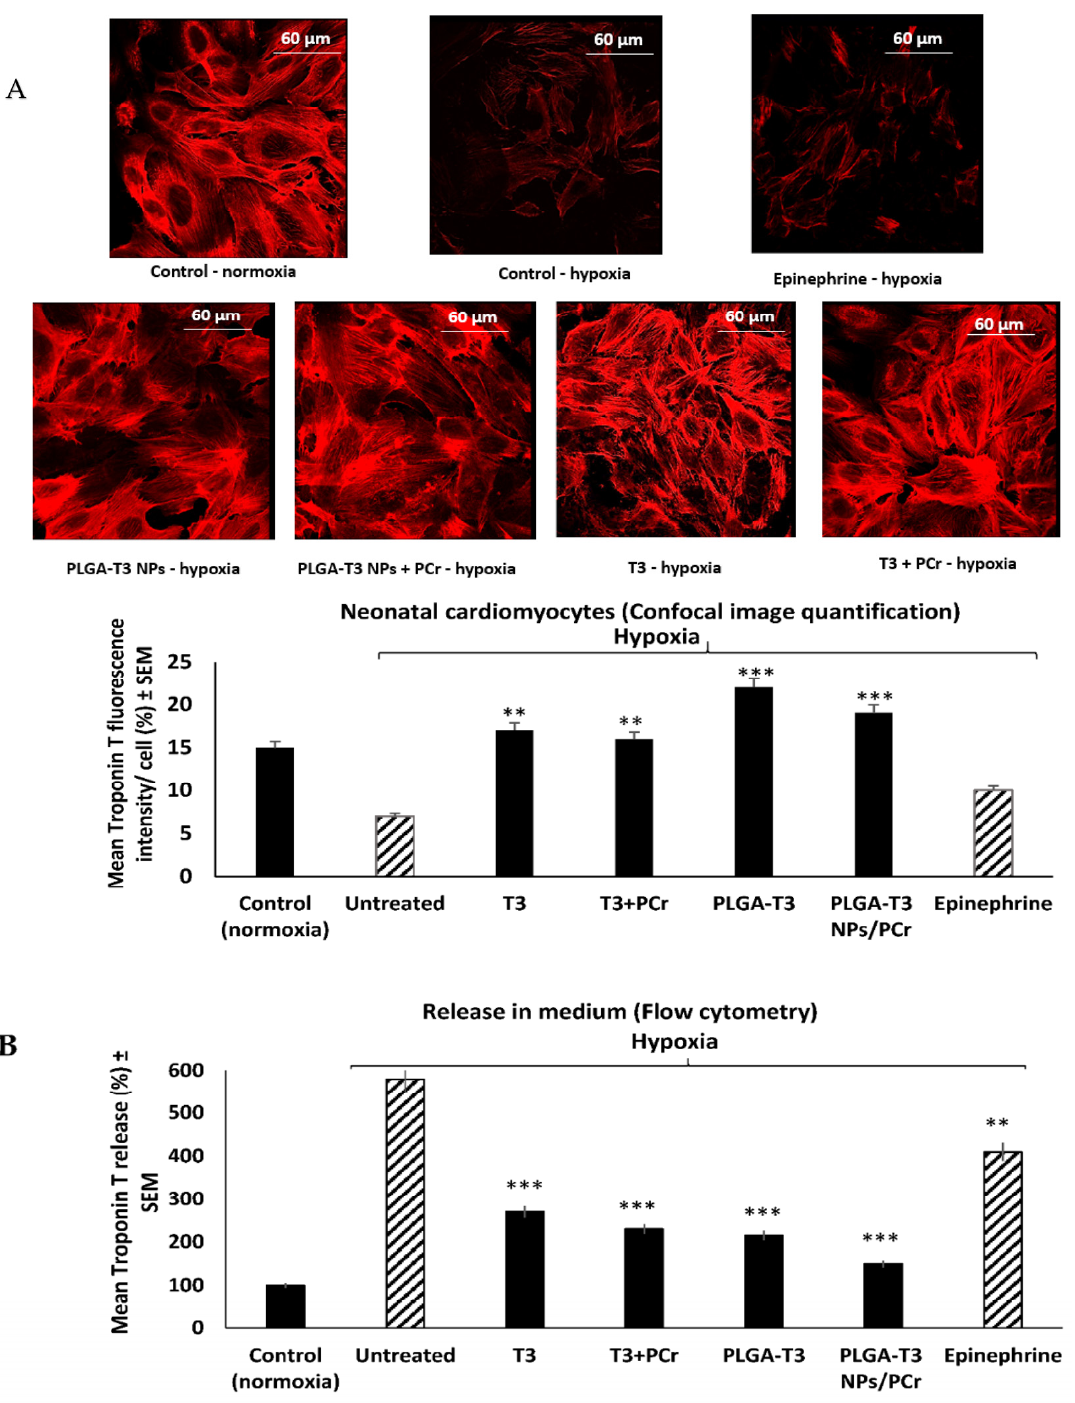
Figure 6. Expression of troponin T in neonatal cardiomyocytes under hypoxic condition. ( A ) Immunostaining by anti- troponin T-PE (confocal microscopy). ( B ) Quantitation of troponin T in neonatal cardiomyocyte and in medium. ** p < 0.05, *** p < 0.001 versus untreated control, with full reversal and improvement versus control under normoxic condition.These results suggest that of PLGA-T3 NPs and PLGA-T3 NPs/PCr inhibit the damaging effect of hypoxia on